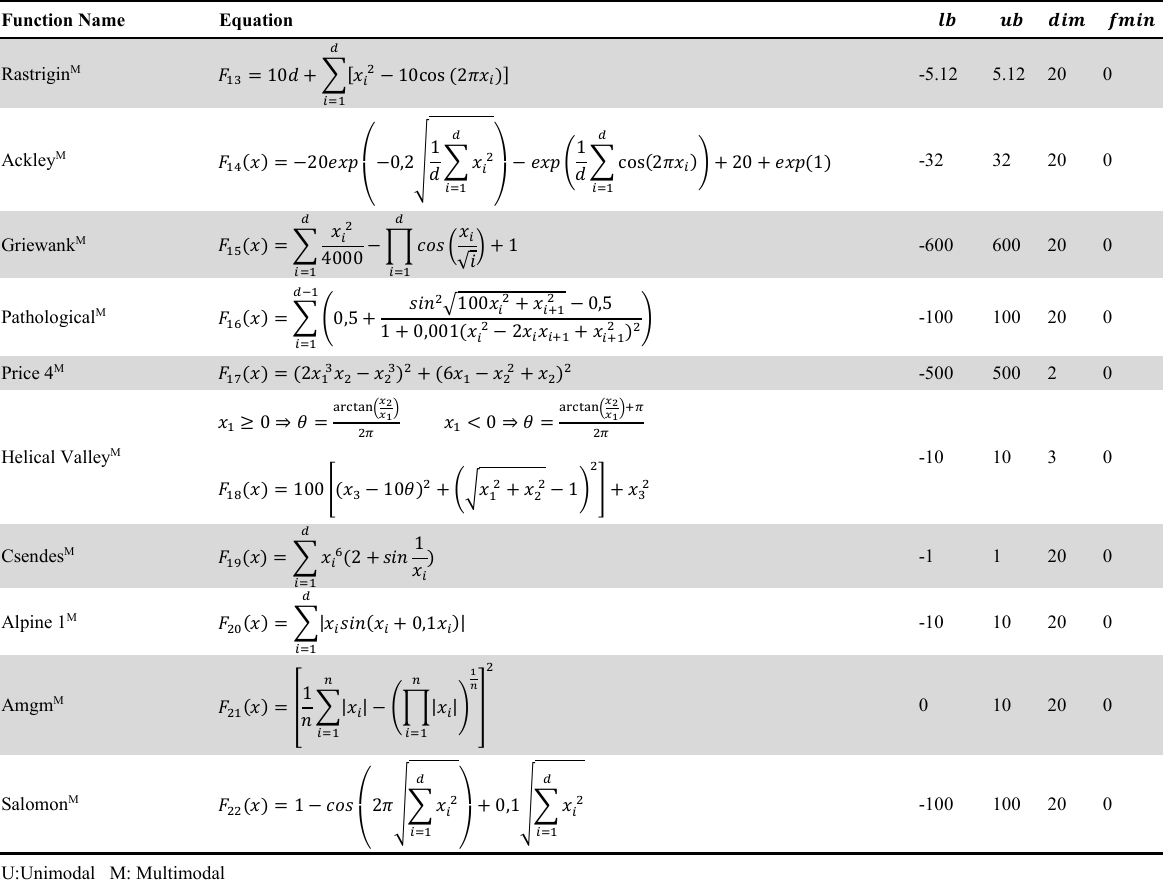
Benchmark functions used in the study (Continued)